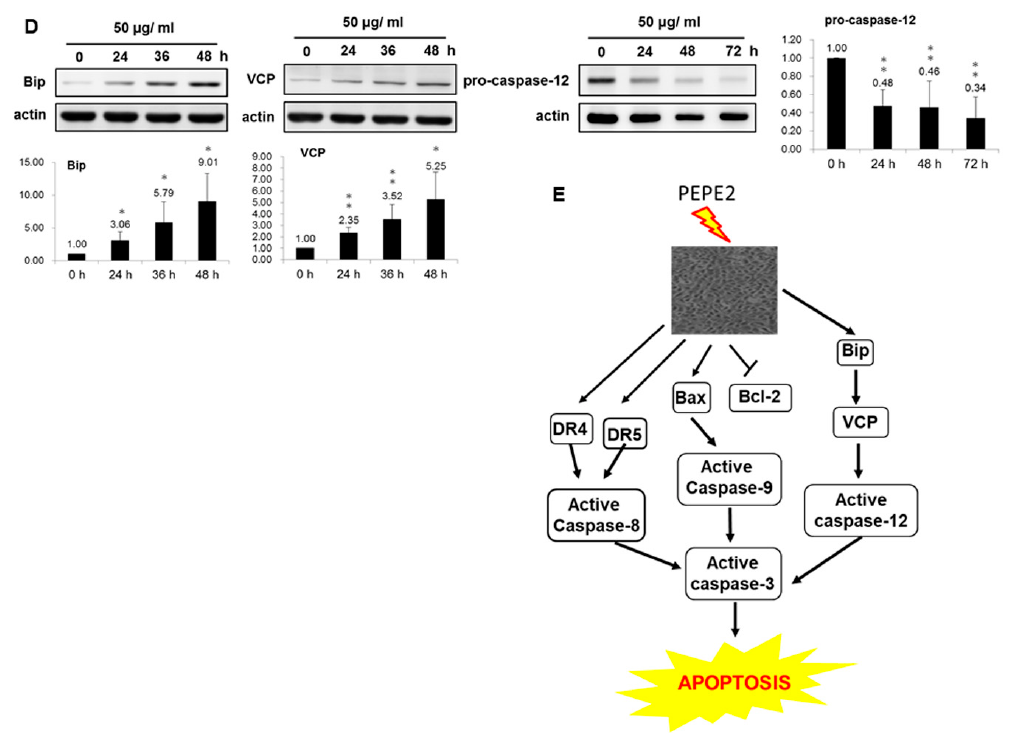
Figure 3. The molecular mechanisms of apoptotic pathway evoked in PEPE2-incubated UBUC cells. T24 and J82 cells were treated with 50 and 20 μ g/mL PEPE2 respectively. Then the protein levels of ( A ) pro-/cleaved caspase-3; ( B ) pro-/cleaved caspase-8, DR4 and DR5; ( C ) pro-/cleaved caspase-9, Bax and Bcl-2 and ( D ) Bip, VCP and pro- caspase-12 in PEPE2-treated T24 cells were measured using western immunoblotting as described in the supporting information. The 0.1% ( v / v ) DMSO-treated UBUC cells were used as the solvent control; ( E ) The proposed molecular apoptotic pathway provoked in the PEPE2-treated UBUC cells. The immunoblot in each figure was the representative result of at least three independent experiments. The diagram (ratio (mean ± standard deviation (S.D.)) under each immunoblot indicated the ratio of the normalized protein intensity (observed protein/actin) of PEPE2-treated cells at the indicated time interval, divided by that at the 0-h time point.* p ≤ 0.05, ** p ≤ 0.01, *** p ≤ 0.001.